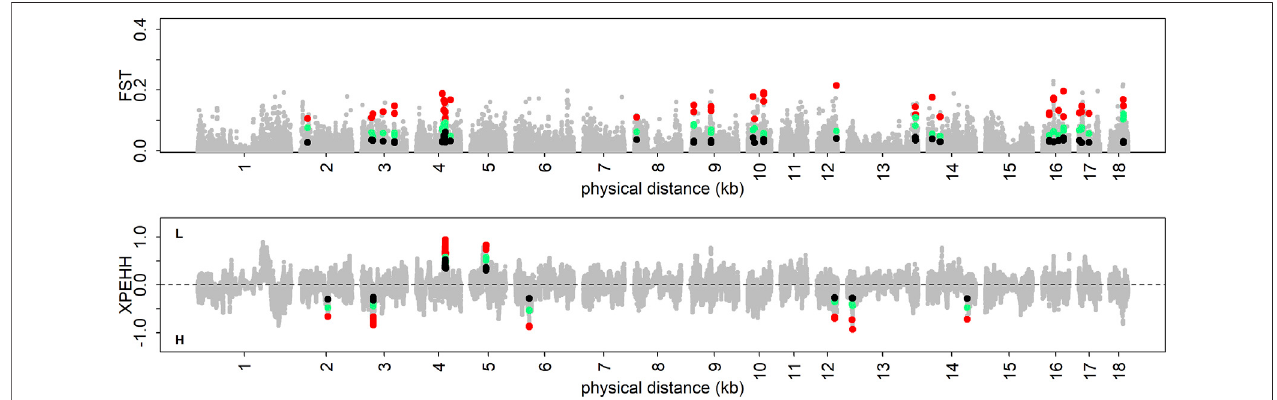
FIGURE 3 | Visualization of trait-speci fi c selection signatures for DL. The colored dots represent trait-speci fi c selection signatures.